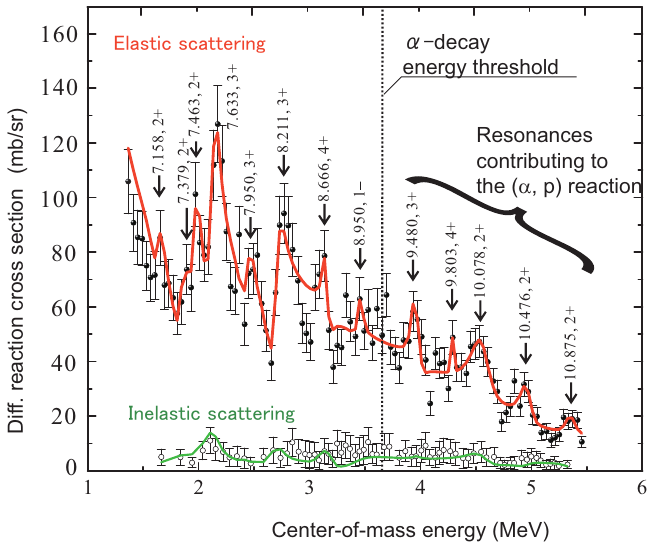
Figure 2. Excitation function of 25 Al + (cid:11) scatterings with an R-matrix analysis. See [7] for